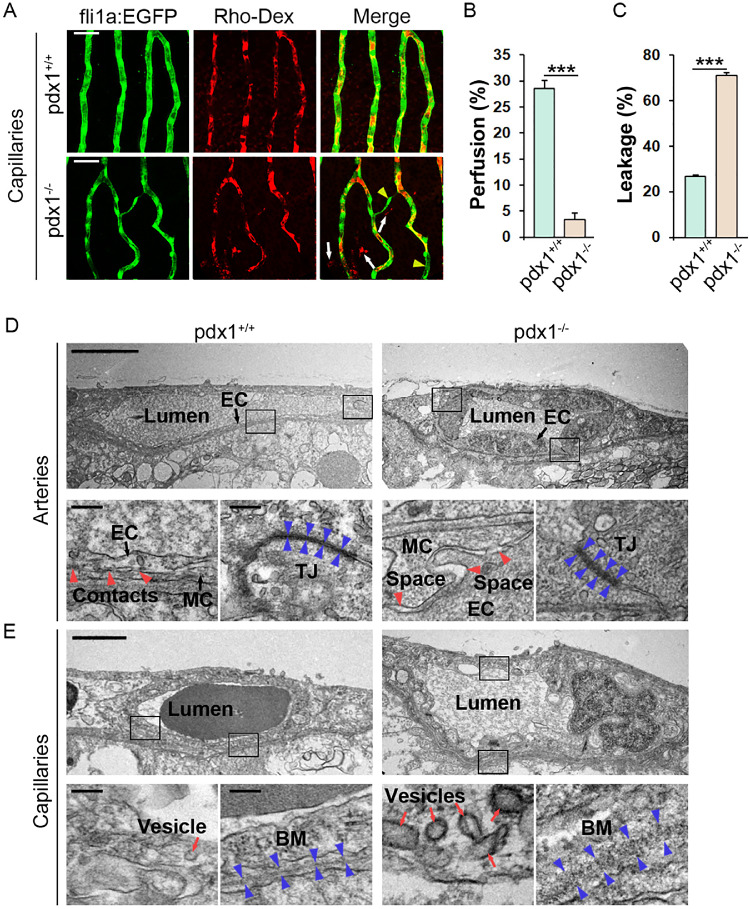
(A) Retinal flat mounts from 6-month-old pdx1 mutants and controls, transgenic for fli1a:EGFP and previously injected with rhodamine-labeled dextran (Rho-Dex, red). Areas of poor Rho-Dex perfusion through the vessels (yellow arrowheads) and areas of Rho-Dex leakage (white arrows) are clearly evident in pdx1 mutants but not in controls. Size bars indicate 50 µm. (B, C) Quantification of perfusion (B) and leakage (C) in the retinal capillaries in 10 regions of 3 individual fish per group from samples as shown in A. ***P < 0.001. (D, E) TEM images of retinal sections from 6-month-old pdx1 mutants and controls focusing on arterial (D) or capillary (E) vessels, showing swollen endothelium, loosened contacts between endothelial cells (EC), and mural cells (MC, red arrowheads), and partially dissolved, loosened tight junctions (TJ, blue arrowheads) in the arteries of mutants compared with controls (D). Also shown is an increased number of vesicles (red arrows), and disrupted basement membrane (BM) in the capillaries of mutants compared with controls (E). Black boxes in the overview images (upper rows) indicate the areas magnified in the images below (lower rows). Size bars in overview and magnified images indicate 5 µm and 100 nm, respectively.